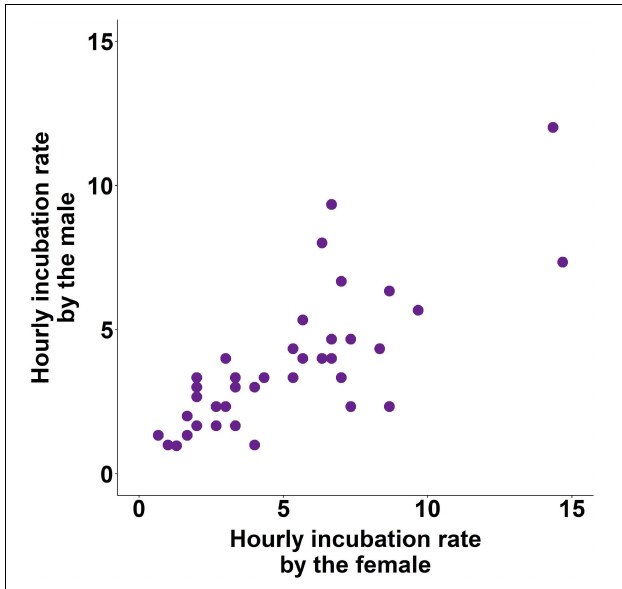
FIGURE 1 | Hourly incubation rate in zebra finch pairs.